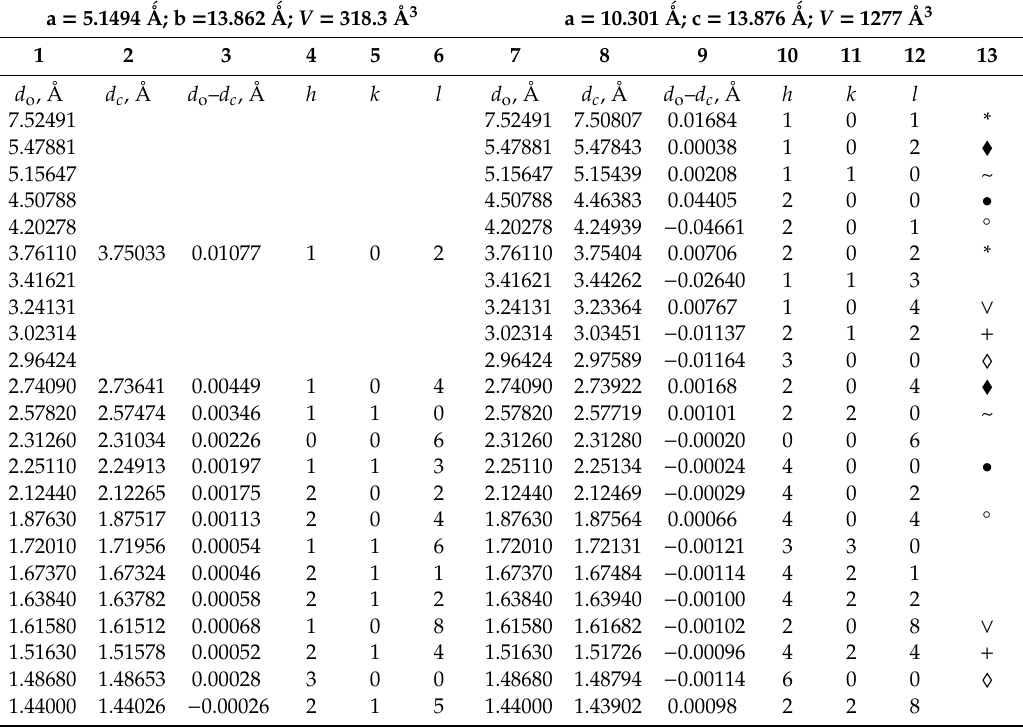
Table 6. Results of indexing: columns 2–6, for the structure R3c; 8–13, for a lattice with a super-structure; 1 and 7, experimental values; d o , experimental values of interplanar distance; d c , interplanar distance calculates due to indexed lattice parameters and reflection indexes ( hkl